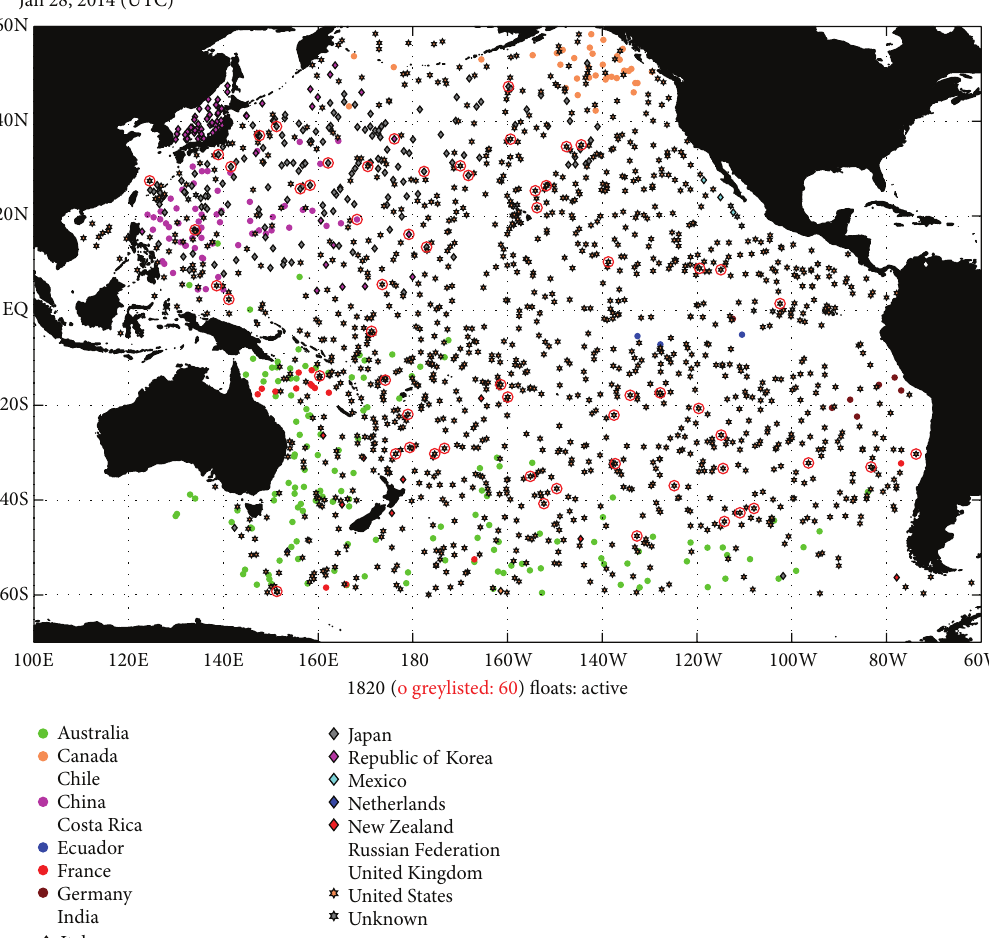
Figure1:LocationoftheArgoprofilingfloatobservinginthePacificOceanactiveonthe28thofJanuary,2014.Eachlocationiscolor-codedby the country of float investigator. Citing from Pacific Argo Regional Center (PARC) (http://www.jamstec.go.jp/ARGORC/location